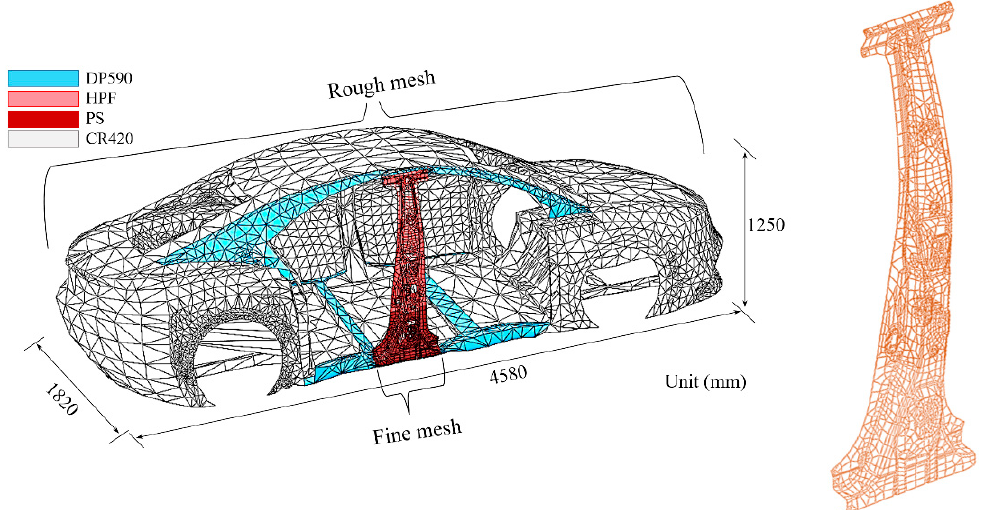
Figure 5. Geometry and material sections of the sedan for side crash test.